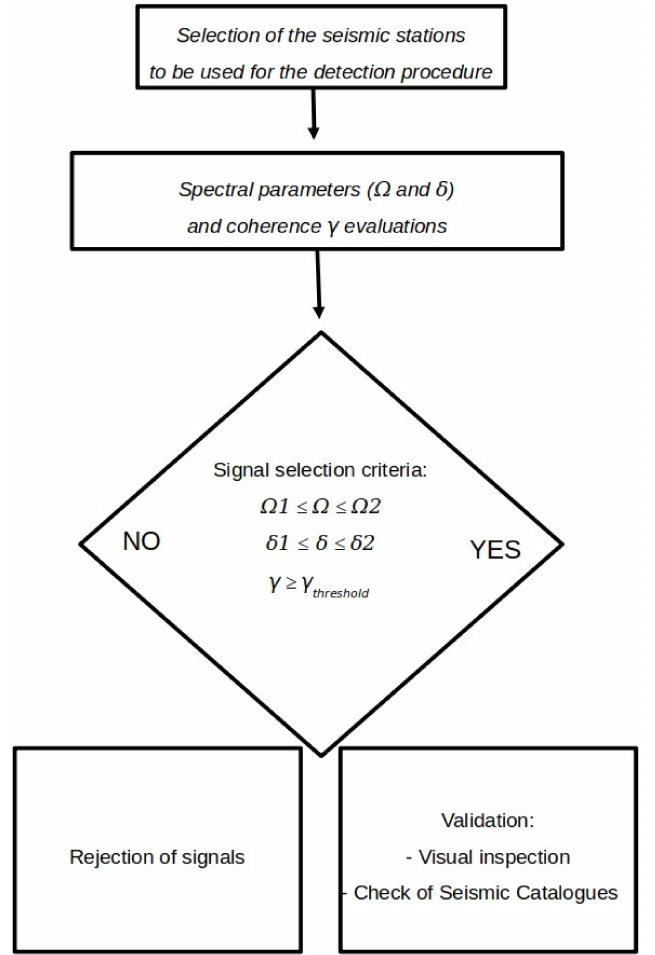
Figure 2. Flowchart of the detection procedure proposed in this work. The three identified signal windows are: 1. 2020 05 02 02:12 UTC, 2. 2020 05 02 12:49 UTC and 3. 2020 05 02 23 50